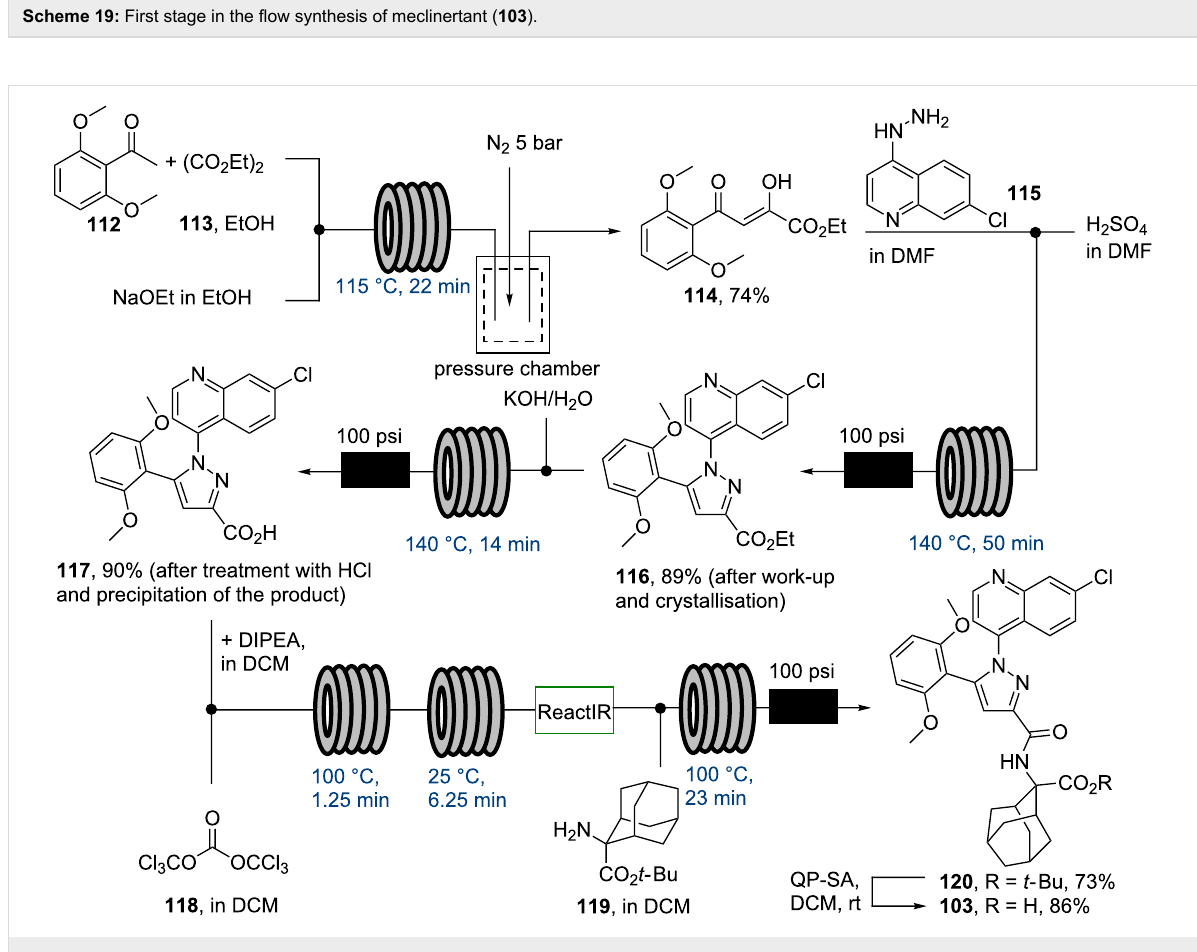
Scheme 20: Completion of the flow synthesis of meclinertant ( 103